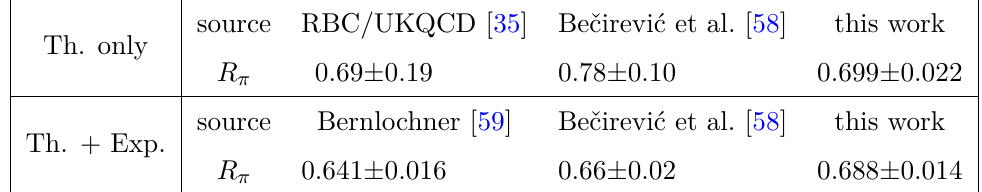
Table 9 . Comparison of theory results for the LFU ratio R π in the